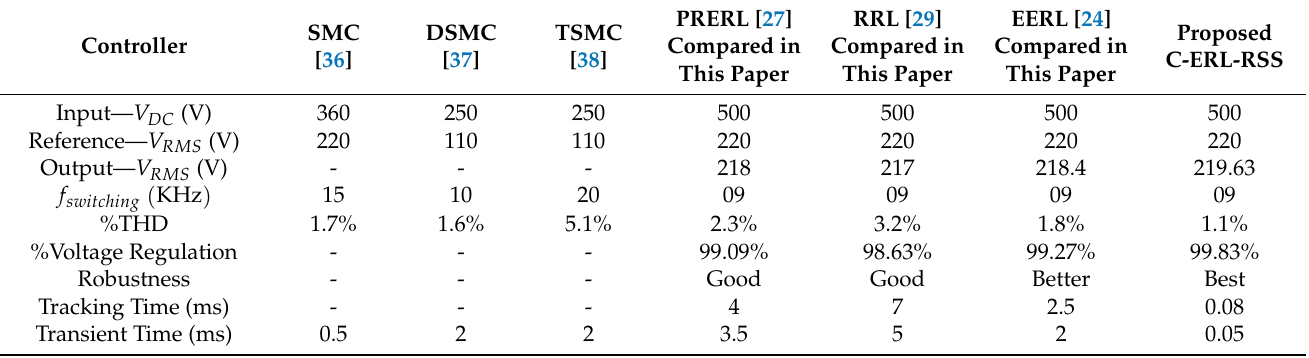
Table 4. Comparison of the proposed composite reaching law with other state-of-the art reaching